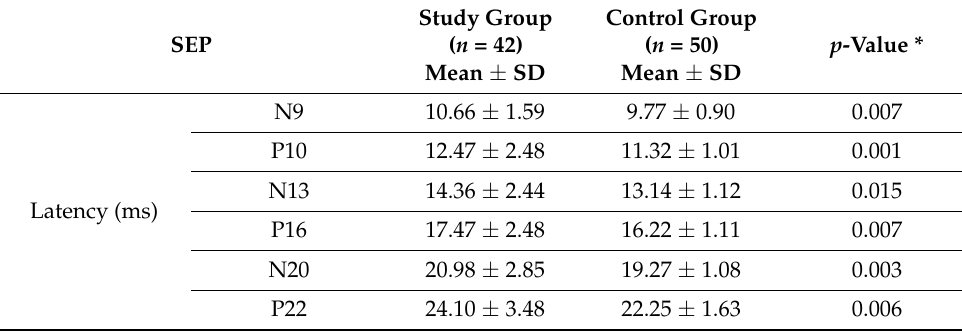
Table 3. SEP parameters in myasthenia gravis patients and in the control